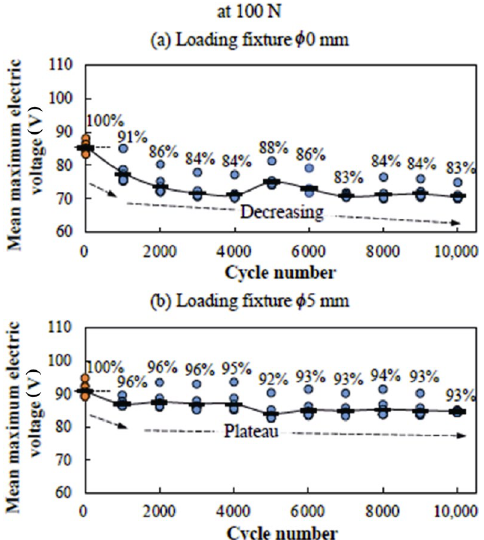
Fig. 14 Maximum voltage generated by PZT ceramic as a function of cycle number for (a) ϕ 0 and (b) ϕ 5 mm loading fixtures at load of 100